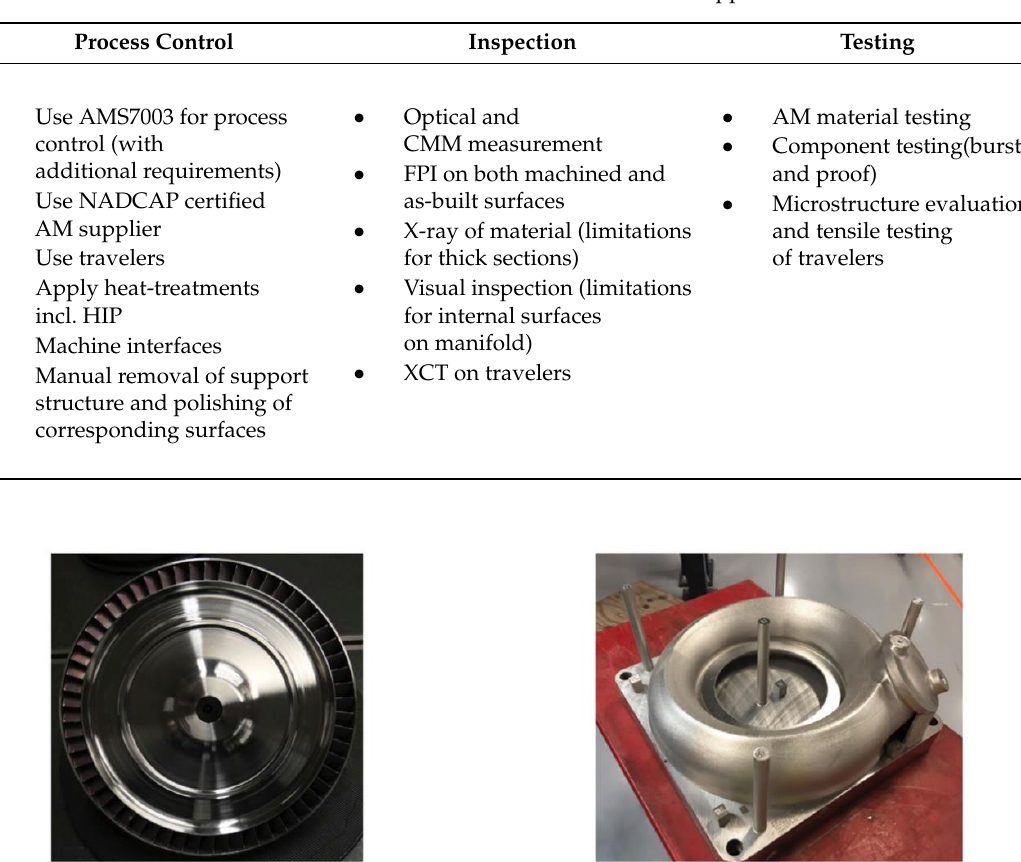
Table 2. Activities related to hardware verification and applied actions.